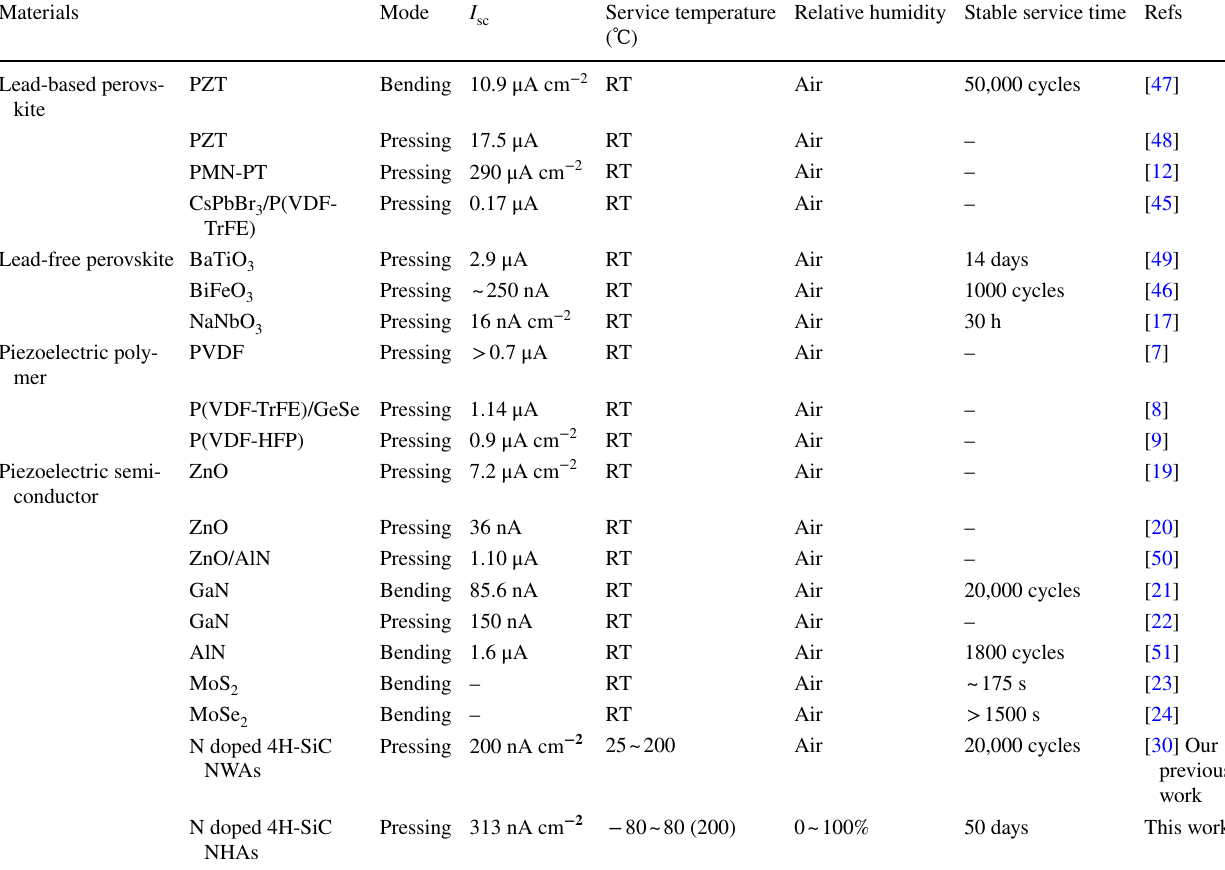
Table 1 The key performance of PENGs based on various